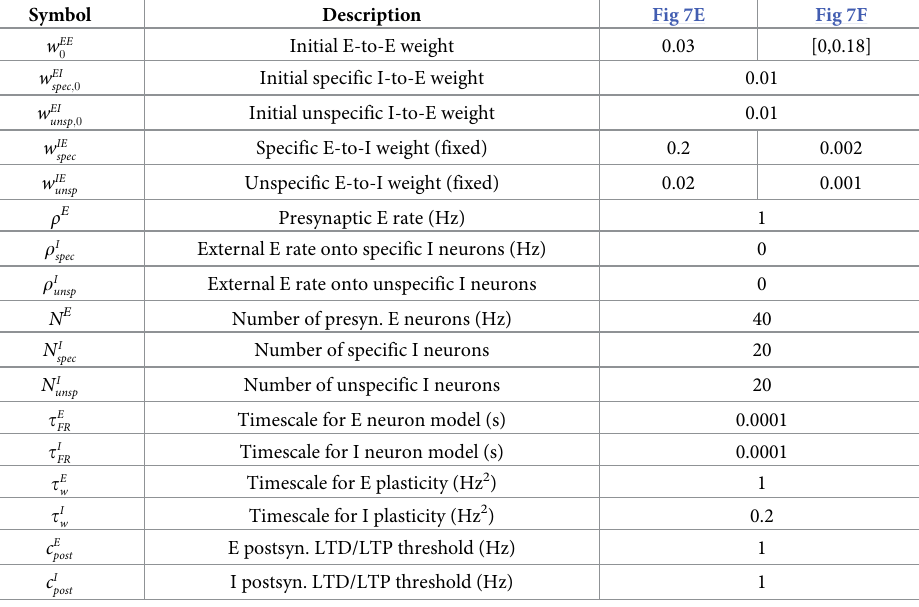
Table 2. Parameter values for Fig 7E and